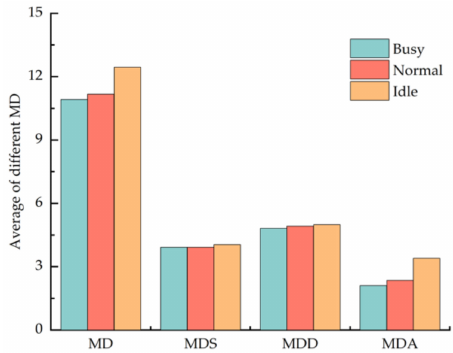
Figure 6. Comparison of average MD after optimization.